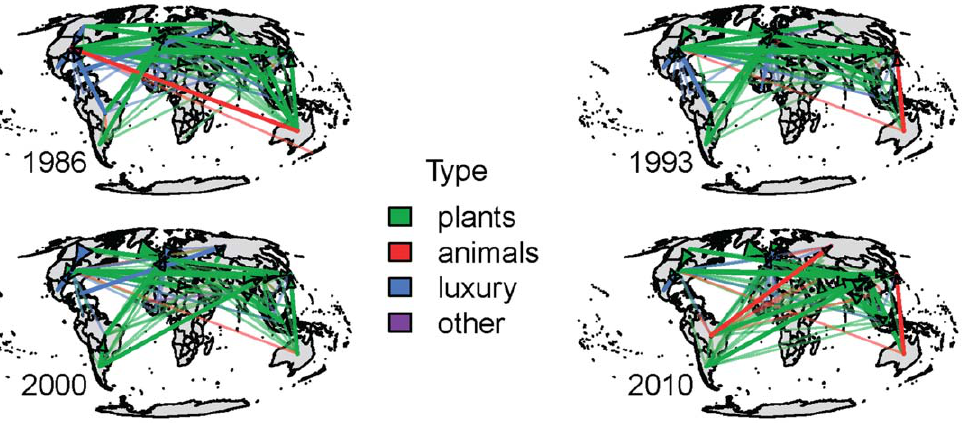
Figure 7. The Network associated with the top 50% of the virtual water flux for the years 1986, 1993, 2000 and 2010. Color in the links based on the most prevalent commodity along the link in terms of total flux through the link. The heavy lines indicate the links which comprise the top 25% of the virtual water flux.